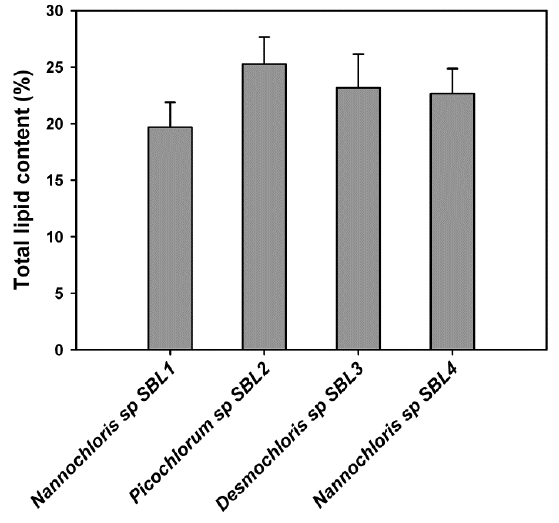
Figure 3. Gravimetric determination of total lipid content (%) determined with the Bligh & Dyer method in all isolated strains. Error bars represent the standard deviation obtained from four replicates.